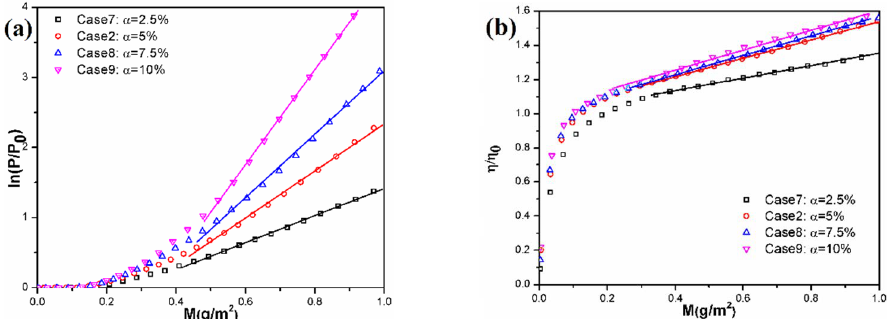
Figure 11. ( a ) Logarithmic scaling of the normalized pressure drop and ( b ) dynamic changes in normalized capture efficiency with different packing densities.